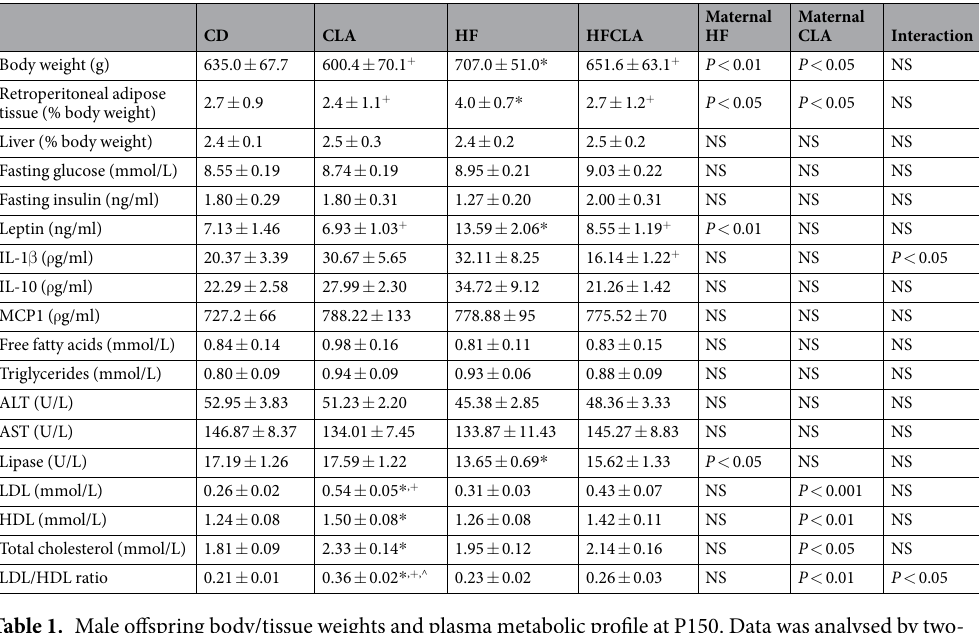
Table 1. Male offspring body/tissue weights and plasma metabolic profile at P150. Data was analysed by two- way ANOVA ( n = 5–6 litters/group). Data expressed as means ± SEM, where * P < 0.05 vs CD, + P < 0.05 vs HF and ^ P < 0.05 vs HFCLA.